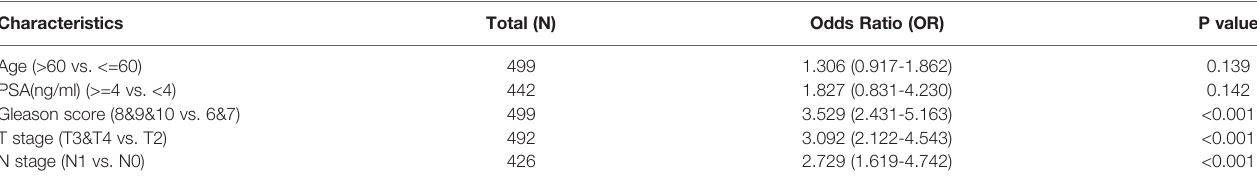
TABLE 2 | Univariate regression analysis associated with high CDCA8 expression.